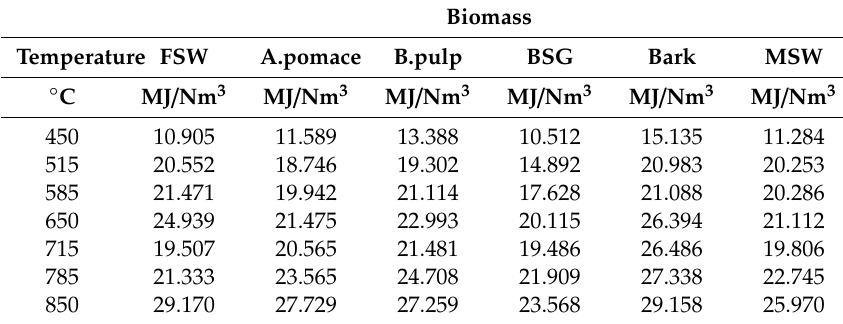
Table 4. Net calorific value (Lower Heating Value) (LHV) of non-condensable gases from pyrolysis of the analyzed biomasses, expressed as average values. C x H y —hydrocarbons, FSW—flavored spirits production waste (lime, grapefruit and lemon), B.pulp—beetroot pulp, A.pomace—apple